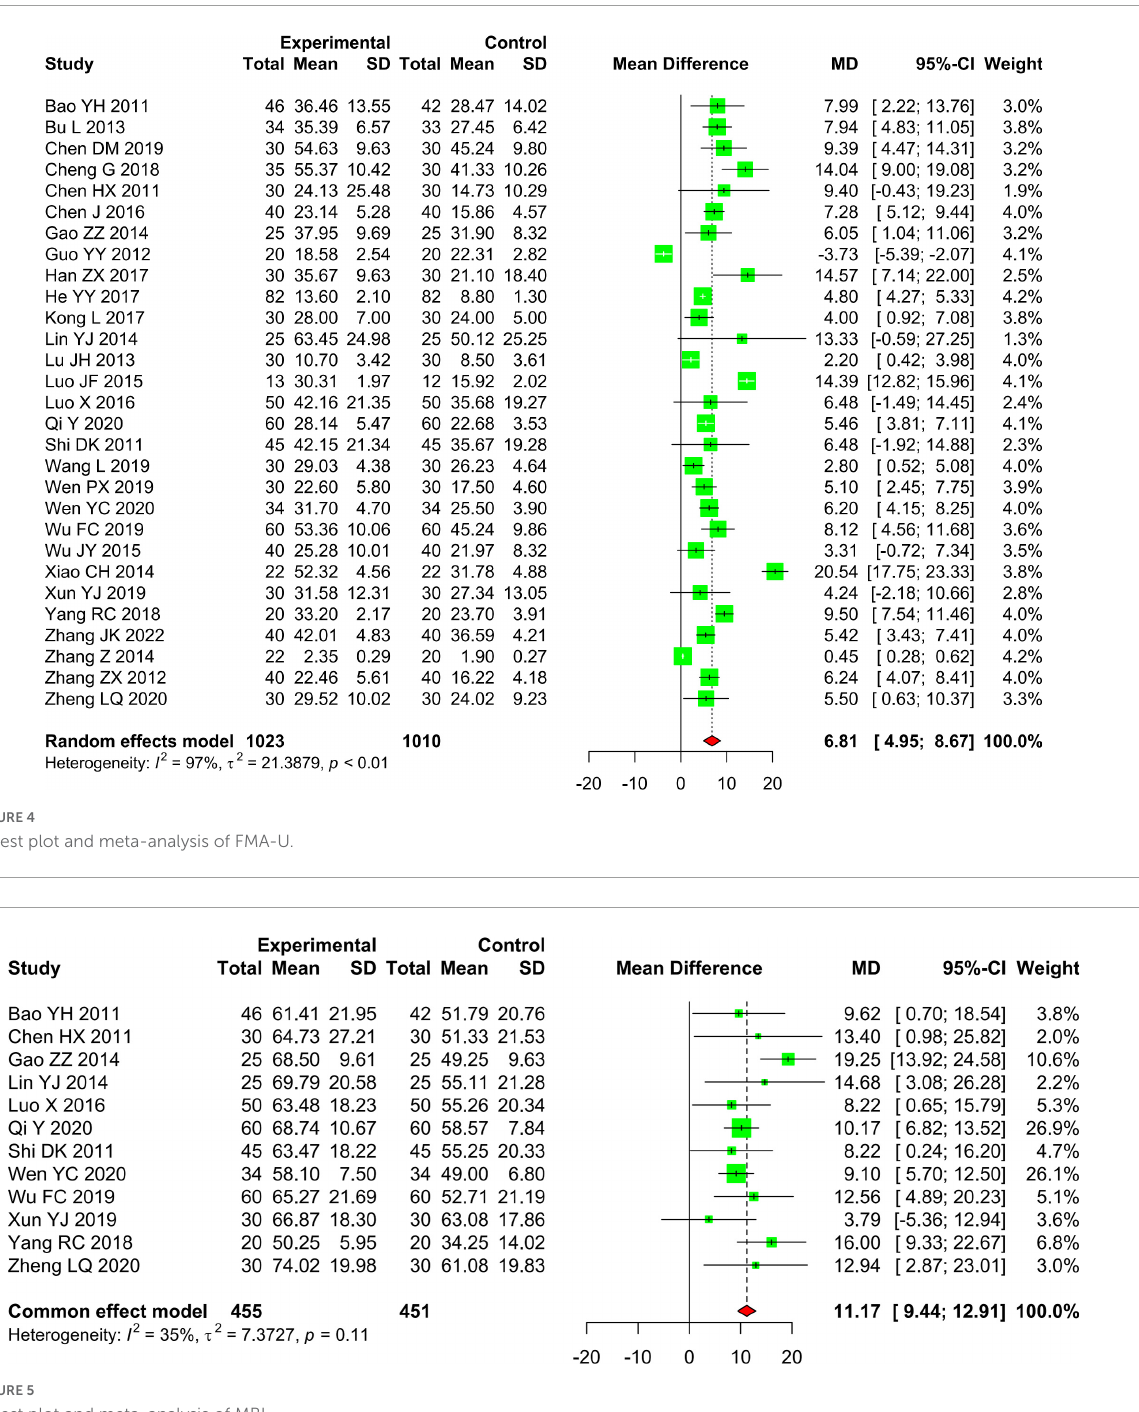
FIGURE5 Forest plot and meta-analysis of